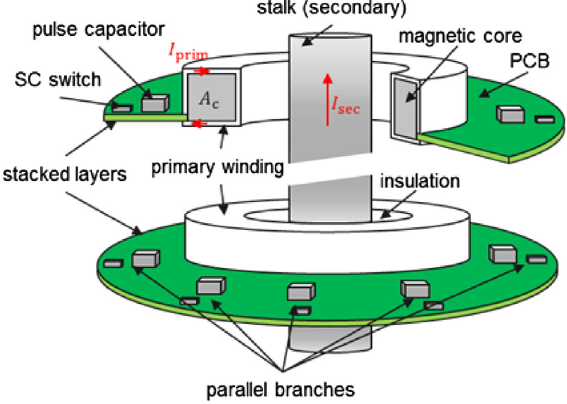
FIG. 1. Schematic illustration of two inductive adder layers. maximum pulse current capability of the SC switch and/or capacitor. The relatively low system impedance of 6 . 25 Ω requires low resistance and parasitic inductance in the primary circuits. To keep the parasitic inductance as small